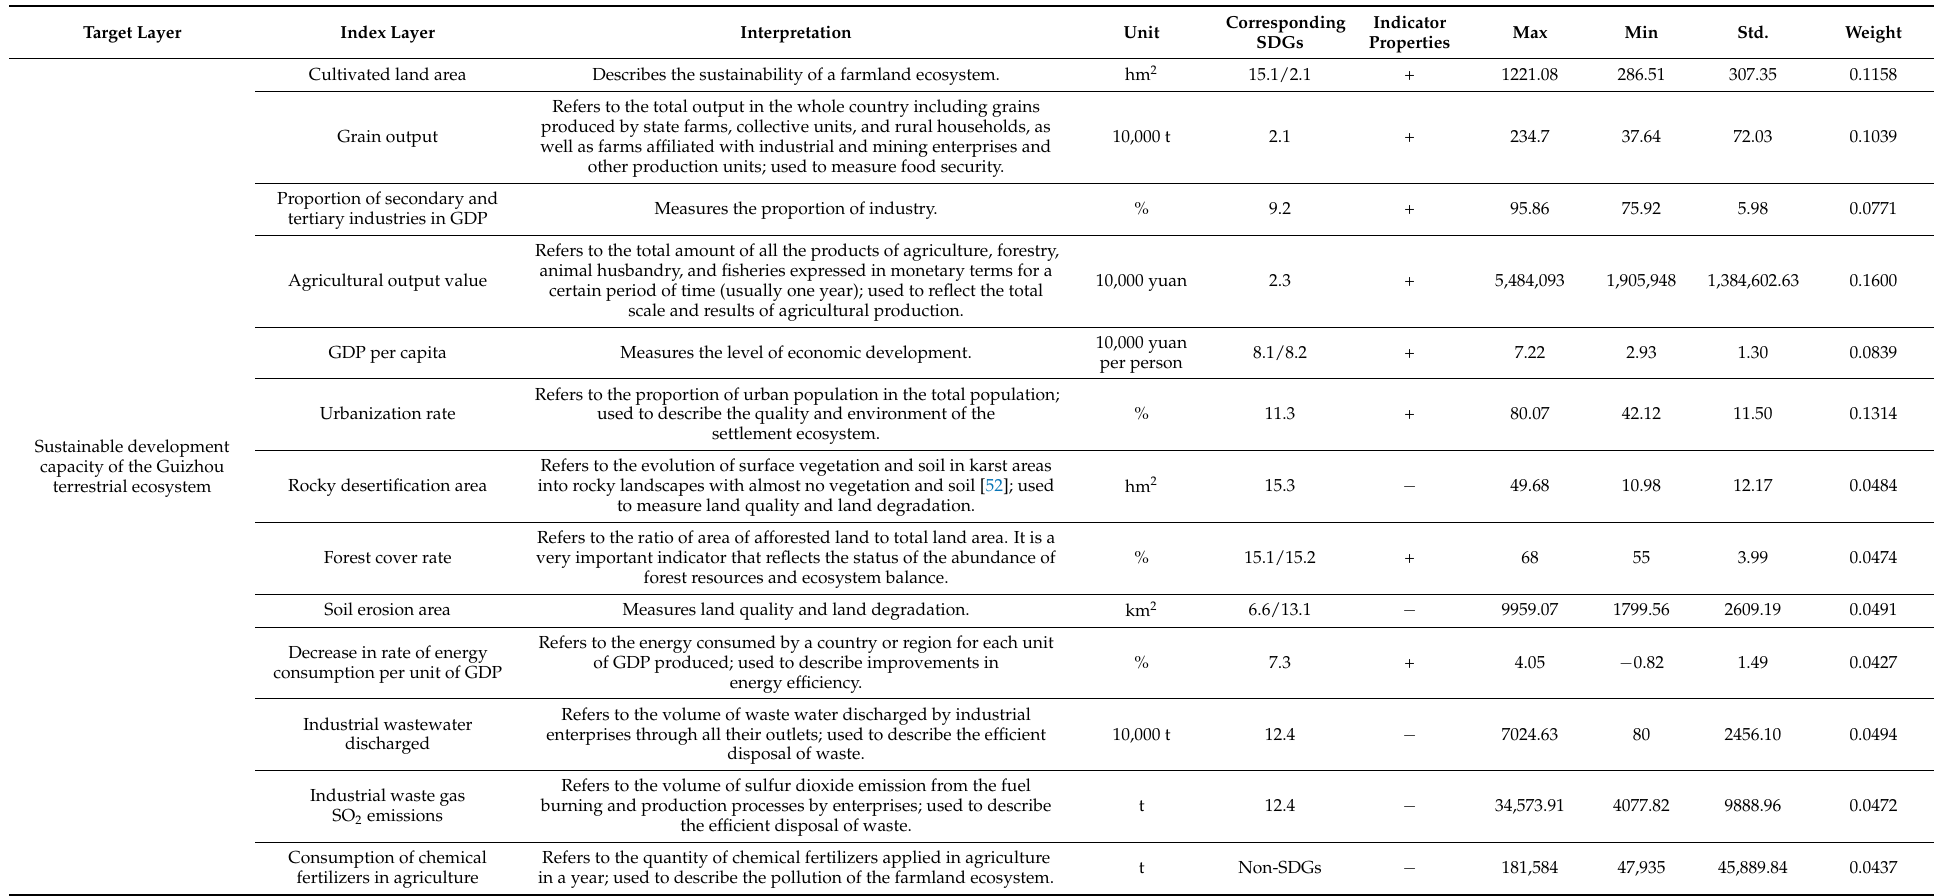
Table 4. The assessment index system for the sustainable development of a terrestrial